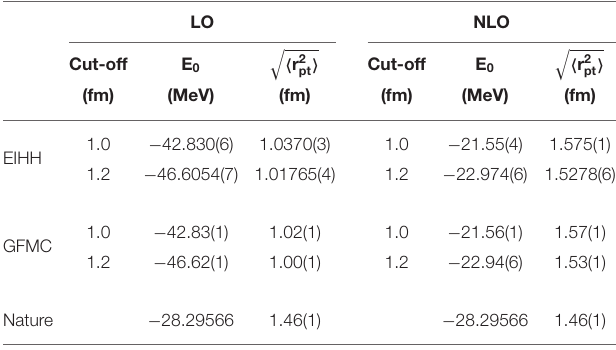
TABLE 2 | Ground-state energies and point-proton radii for the 4 He nuclear system at LO and NLO computed with the EIHH method. LO NLO